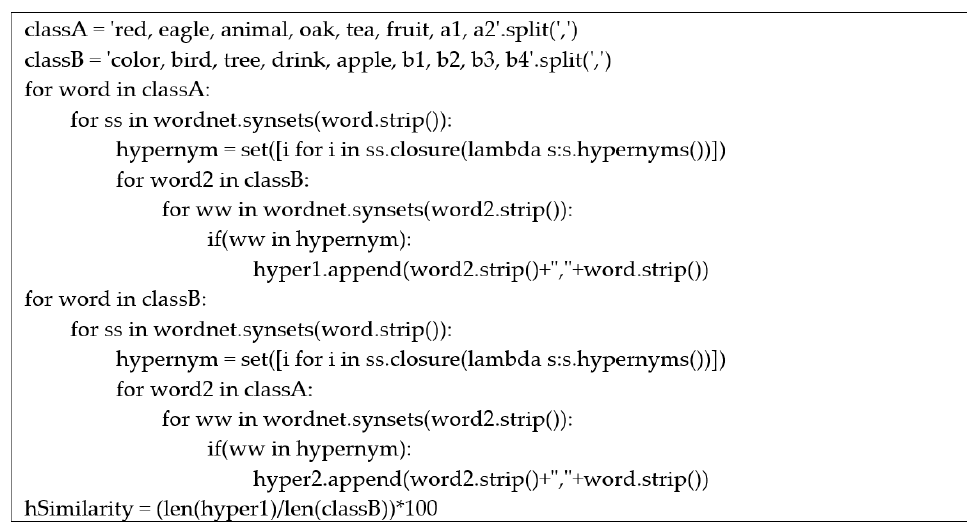
Figure 4. All hypernyms of a word “tree” as extracted from WordNet.